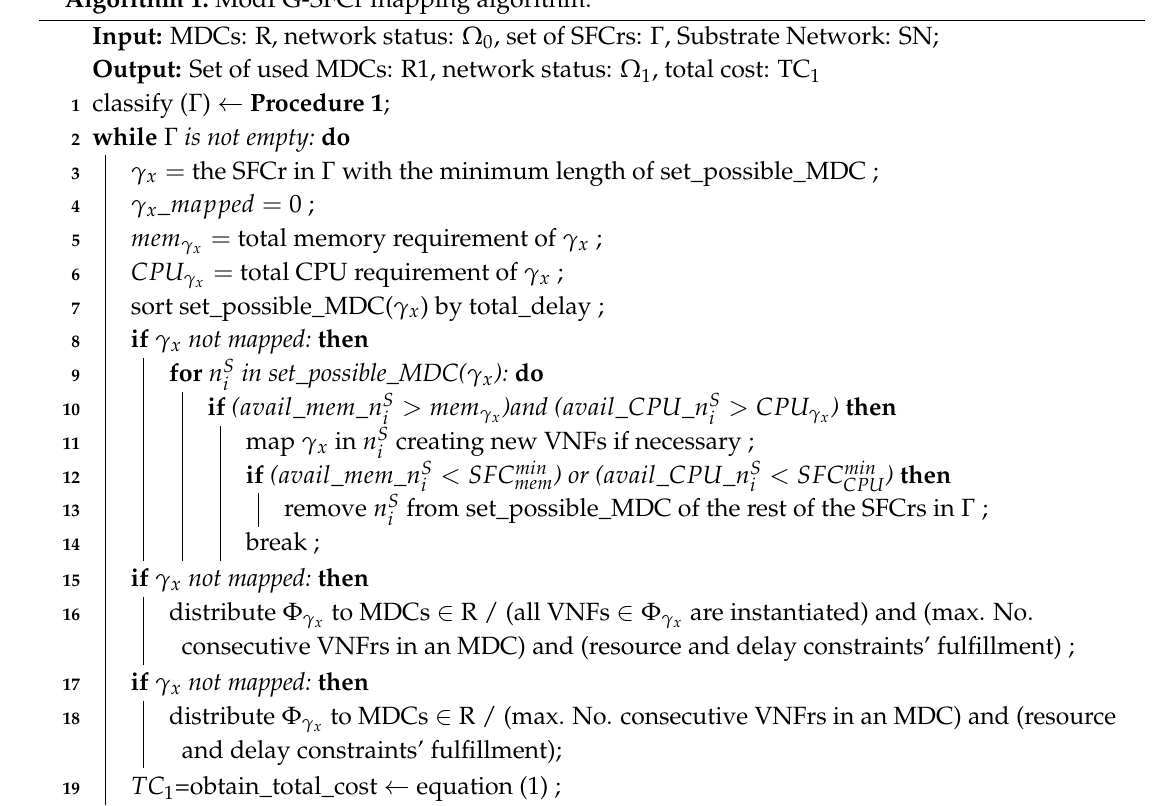
Algorithm 1: ModPG-SFCr mapping algorithm.